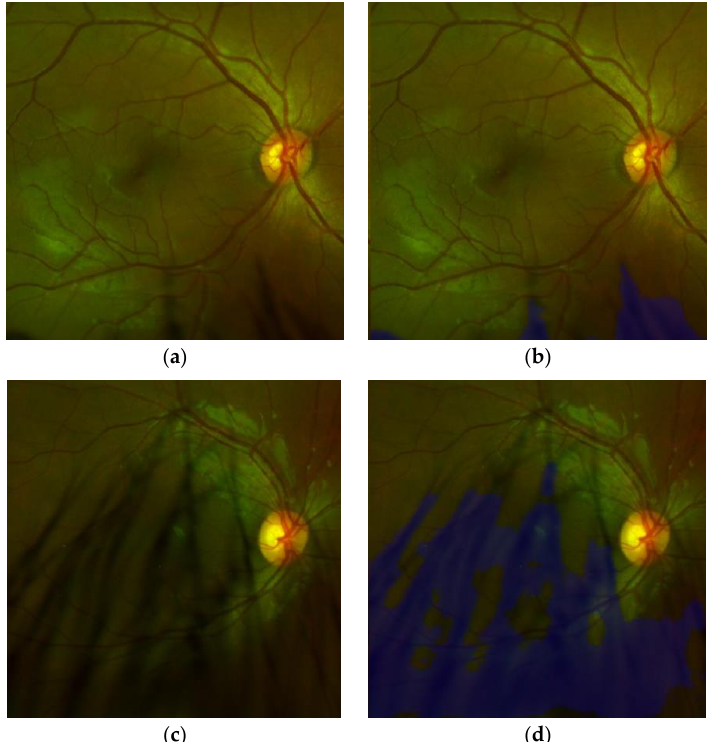
Figure 13. Examples of artefact segmentation in the ROI. ( a ) and ( c ) images of the ROI and ( b ) and ( d ) the ROIs with artefact detected.